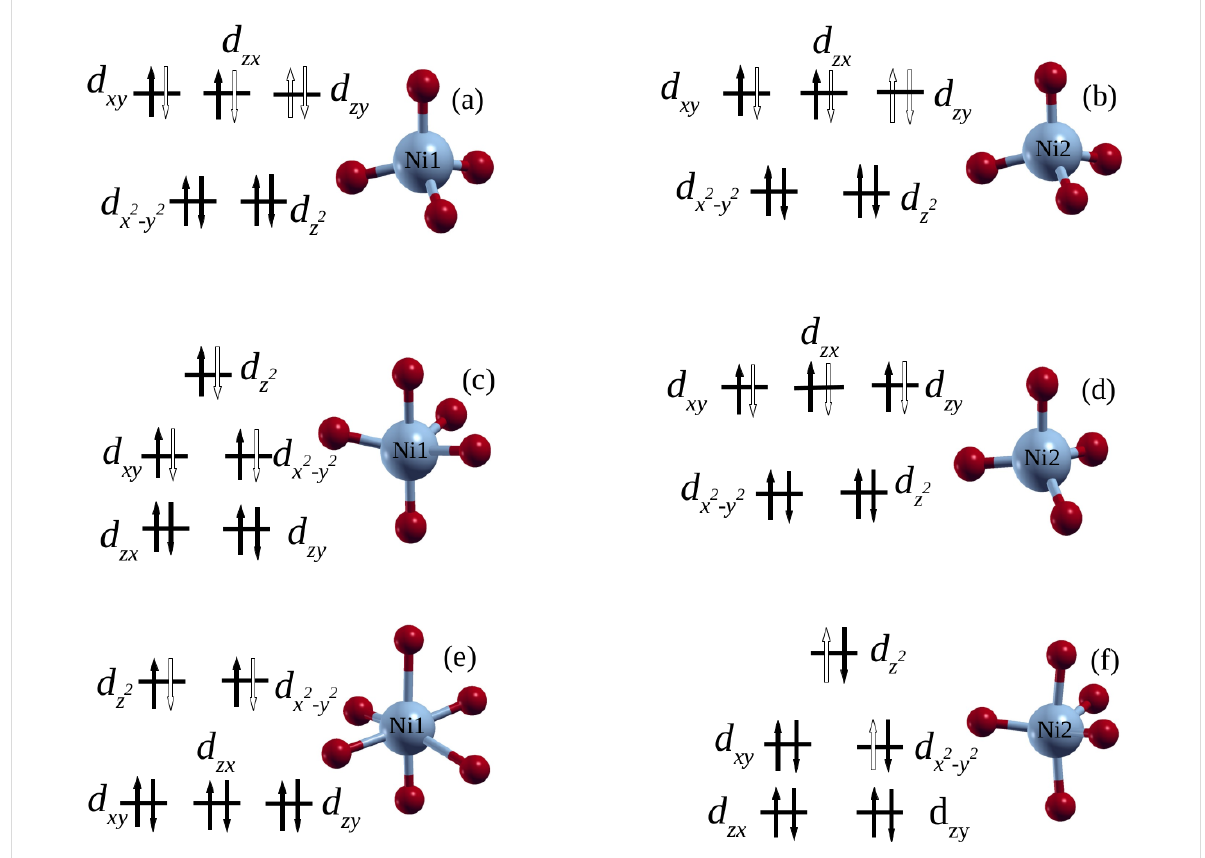
Figure 2: Relaxed nickel geometries and crystal-field splitting diagrams for different Ni-doped zirconia containing varying oxygen vacancy concentra- tions. (a, b) Nickel dopant atoms in tetrahedral geometry in the structure S 0 with Ni1 and Ni2 being spin-up polarized. It should be noted that S 0 has no oxygen vacancies. (c, d) Nickel dopant atoms in trigonal bipyramidal and tetrahedral geometries in the structure S 1 with Ni1 and Ni2 being spin-up polarized. Structure S 1 has one oxygen vacancy. (e, f) Nickel dopant atoms in octahedral and trigonal bipyramidal geometries in the structure S 2 with Ni1 being spin-up and Ni2 being spin-down polarized. Structure S 2 has two oxygen vacancies. In the figures, blue and red spheres represent Ni and O atoms, respectively. Black filled arrows represent occupied electron states while the hollow arrows indicate empty electron